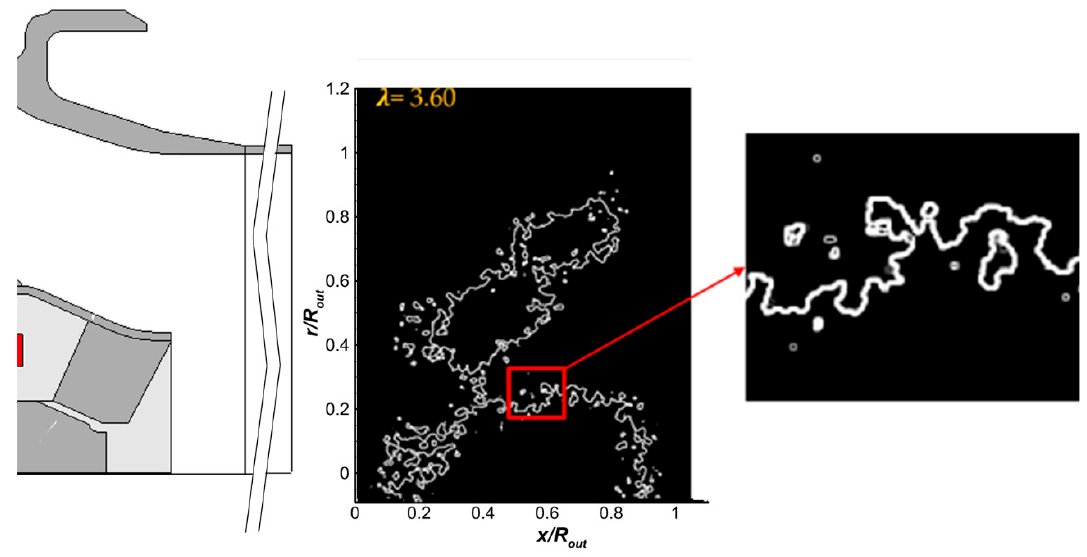
Figure 9. Corrugated flame front for operating point #1—detail of local small-scale behaviour.